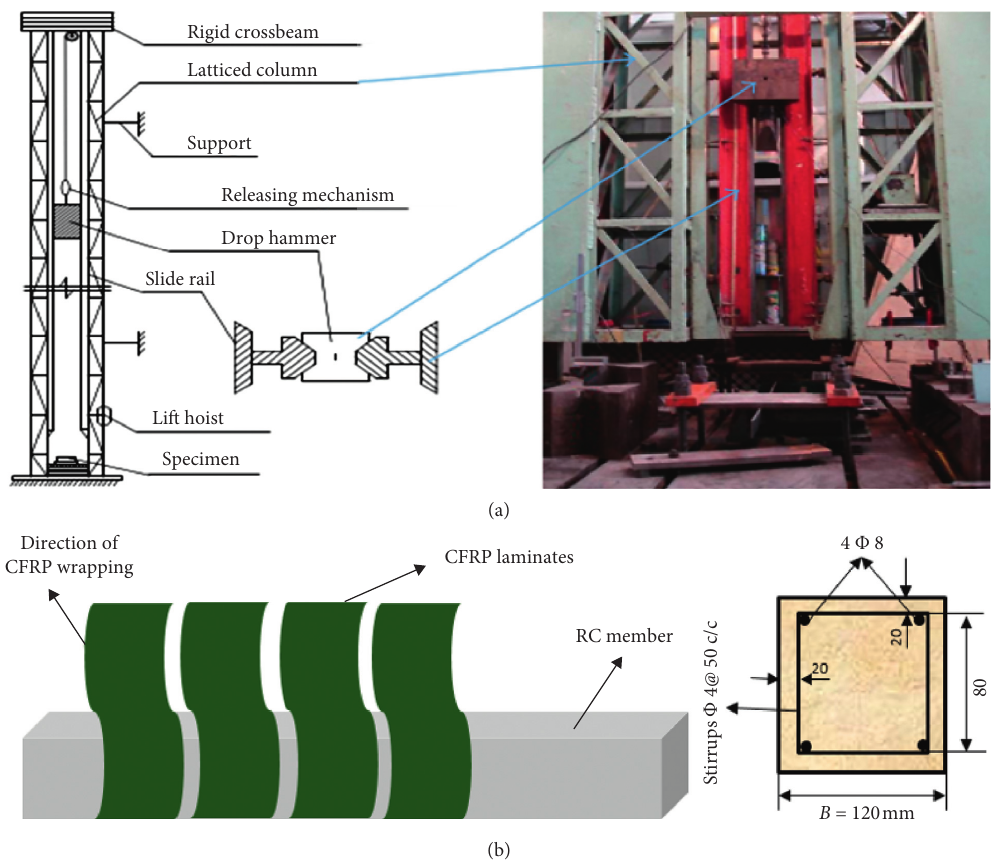
Figure 1: (a) DHR9401 drop hammer test machine. (b) Schematic view of test setup